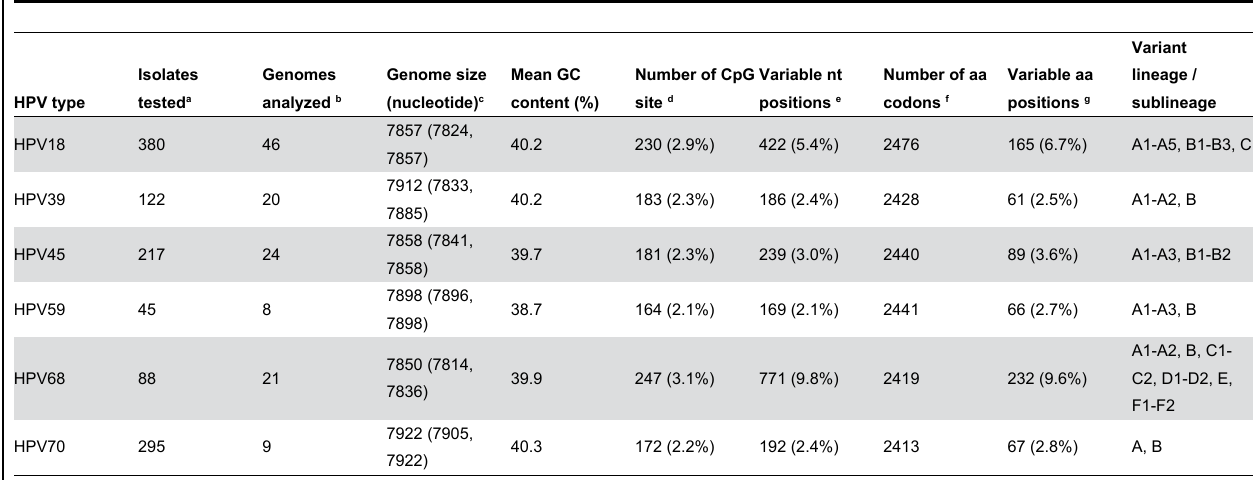
Table 1. Summary of HPV isolates, genome sizes, variability and variant